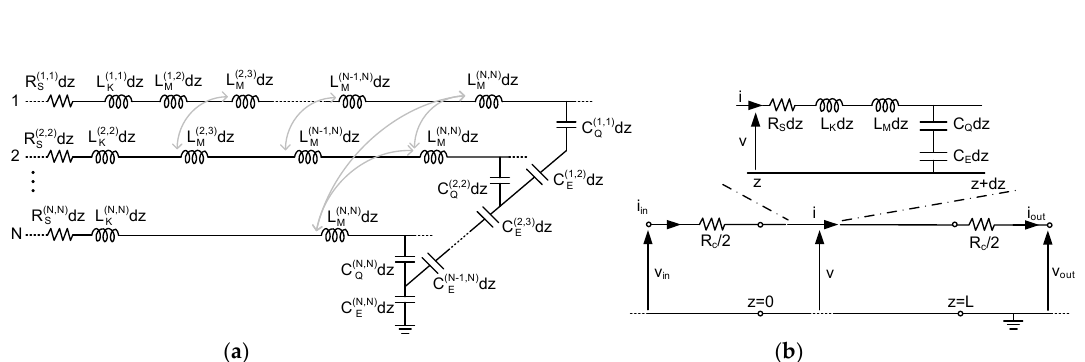
Figure 4. ( a ) Multi-conductor transmission line model and ( b ) equivalent single-conductor (ESC) transmission line model of side-contacted MLGNR interconnect [38].